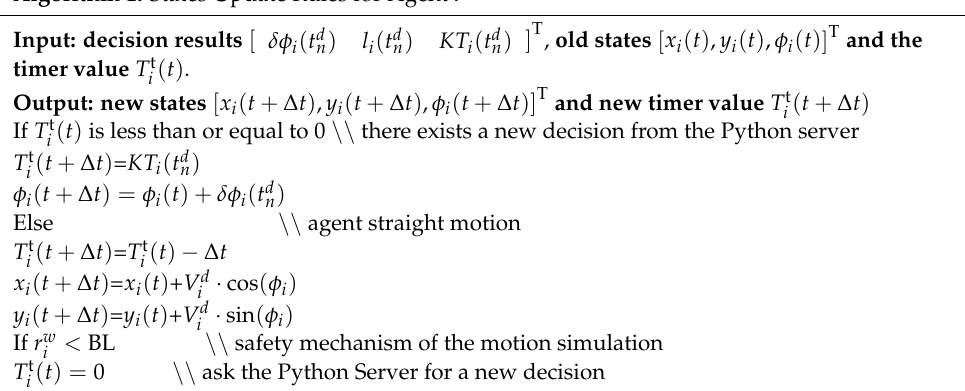
Algorithm 1. States Update Rules for Agent